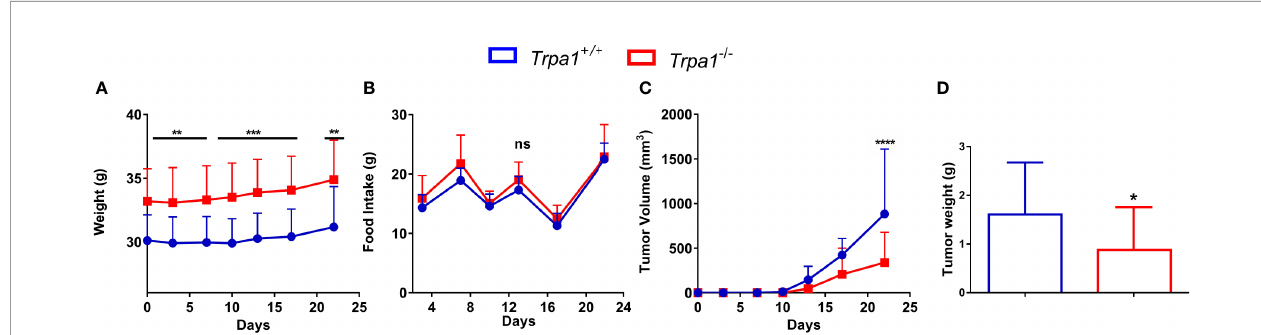
FIGURE 1 | Evaluation of body weight, food intake, and tumor volume of Trpa1 +/+ or Trpa1 -/- mice. Values are shown as mean (n = 13 for Trpa1 +/+ and n=18 for Trpa1 -/- ) ± SD. All temporal analyses were carried out using Two-Way ANOVA followed by Bonferroni post-test. Tumor weight was calculated using unpaired Student ’ s t- test. (A) Animal weight; (B) Food intake; (C) Tumor volume; (D) Tumor weight. *p < 0.05; **p < 0.01; ***p < 0.001; ****p < 0.0001; ns, not signi fi cant, at each time point between